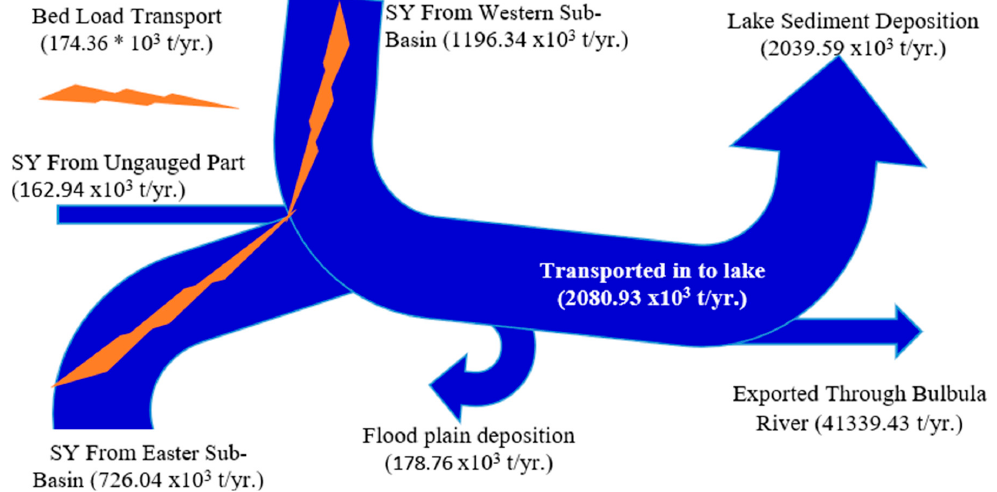
Figure 11. Sediment budget of Lake Ziway.